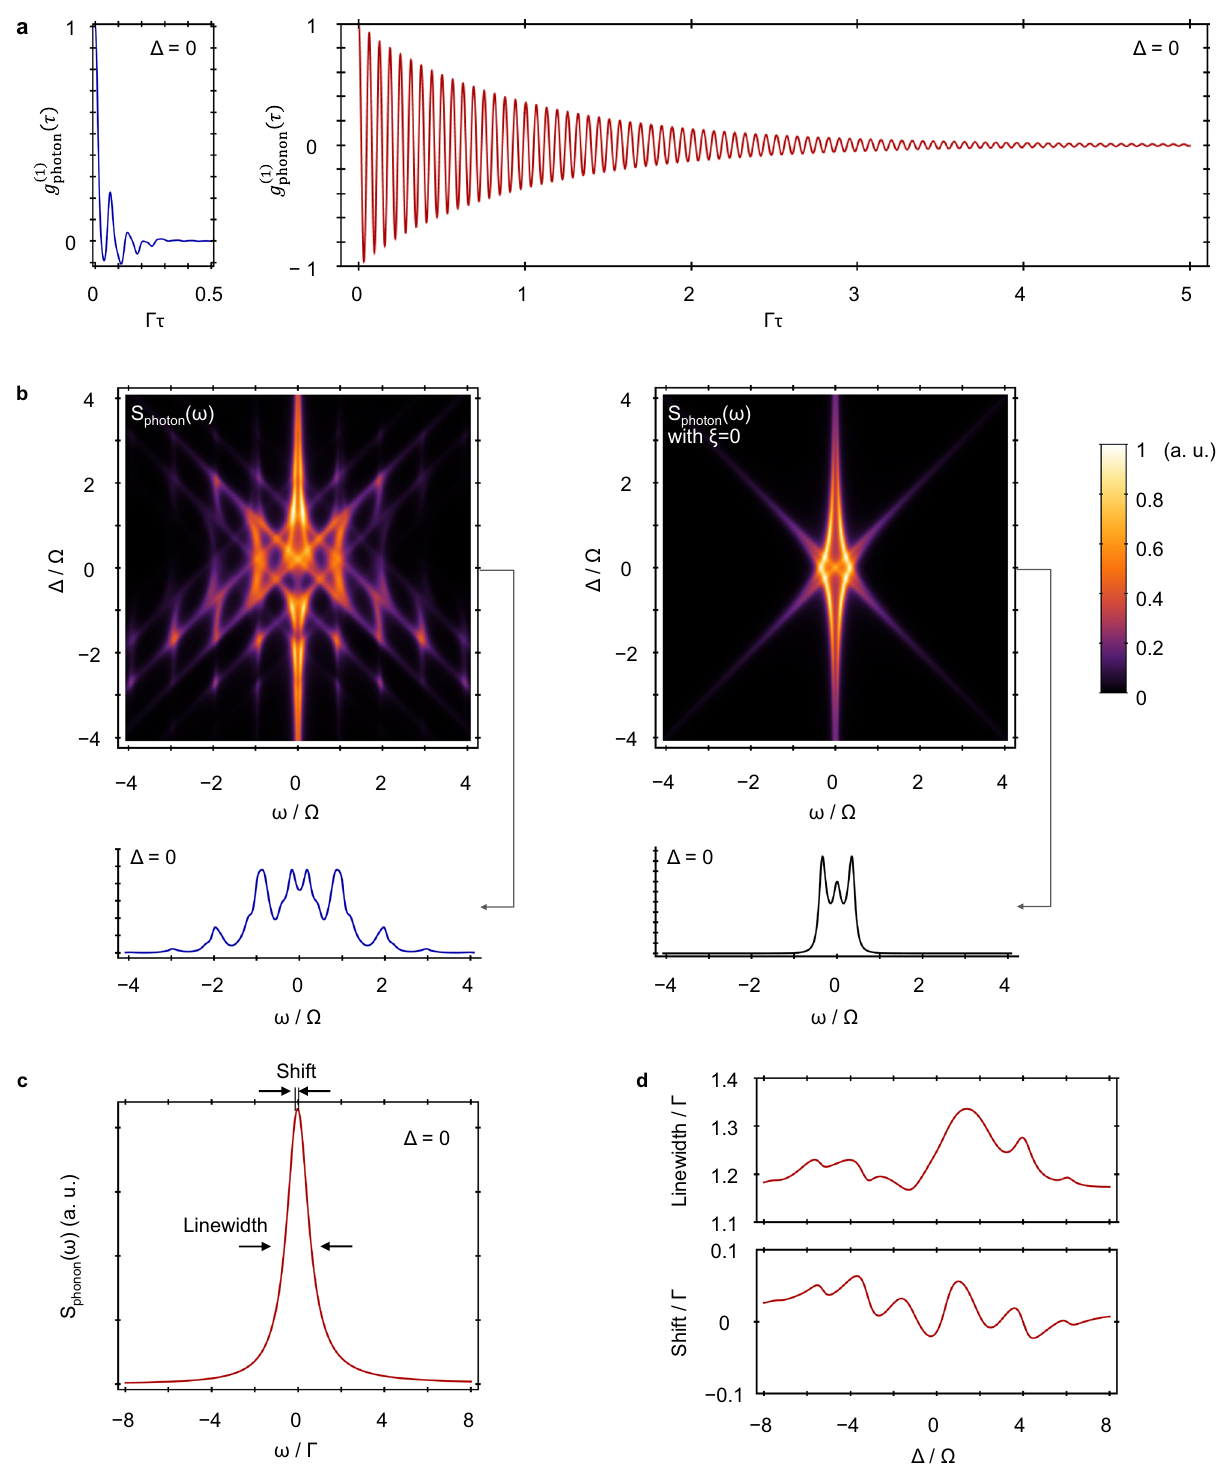
ð τ Þ of intracavity photons and photon